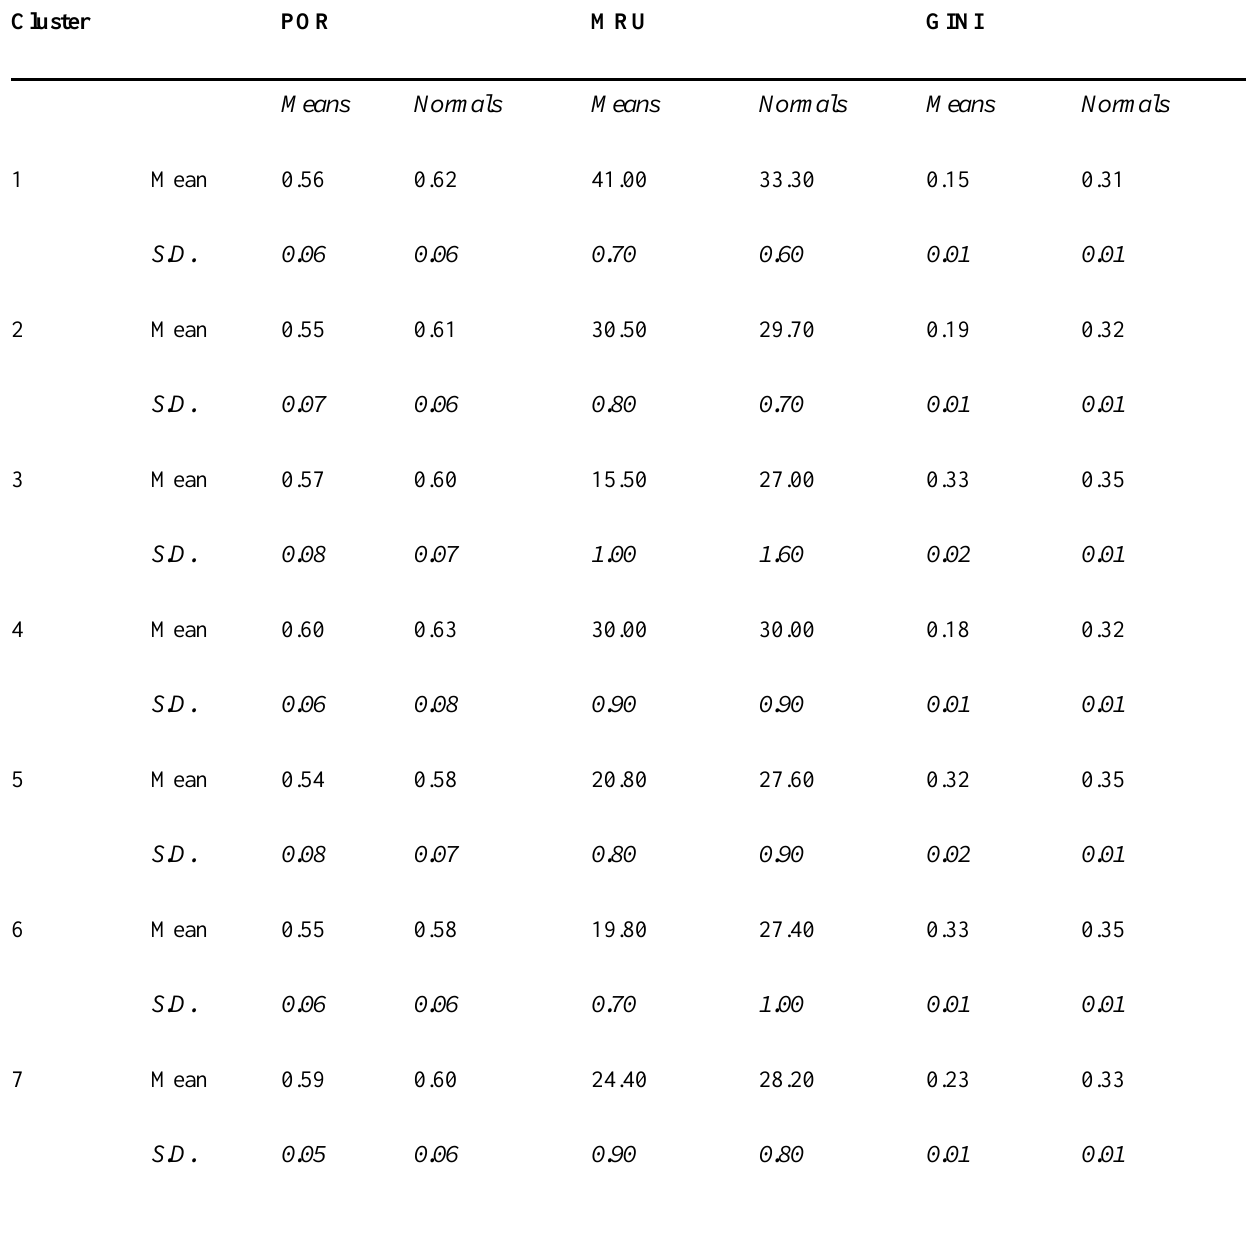
Table 5. Means and standard deviations of metric values by agent category when model was run with mean values and normal distributions for each category. Cluster POR MRU